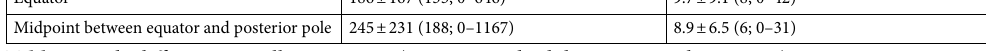
Table 5. Side difference in cell counts/mm (mean ± standard deviation; median; range).